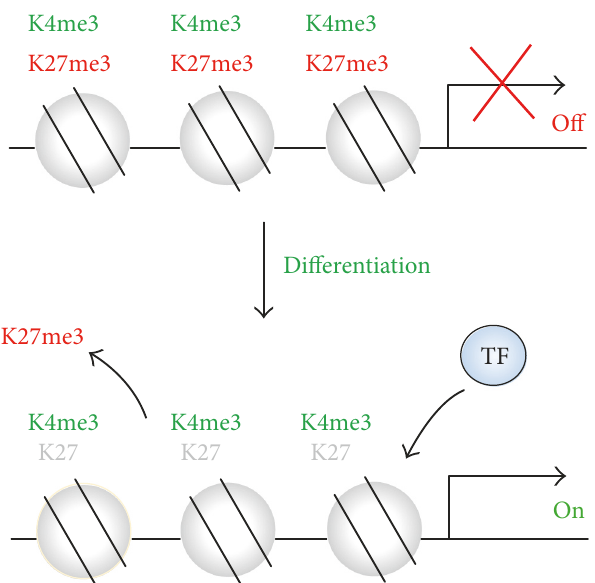
Figure 1: The chromatin regulation of developmental genes in PSCs. In PSCs, developmental genes are marked by bivalent domains containing both H3K4me3 and H3K27me3, which are associated with the transcriptional silencing in the undi ff erentiated state. The removal of H3K27me3 and the binding of transcription factors (TFs) allow rapid transcriptional activation upon di ff erentiation